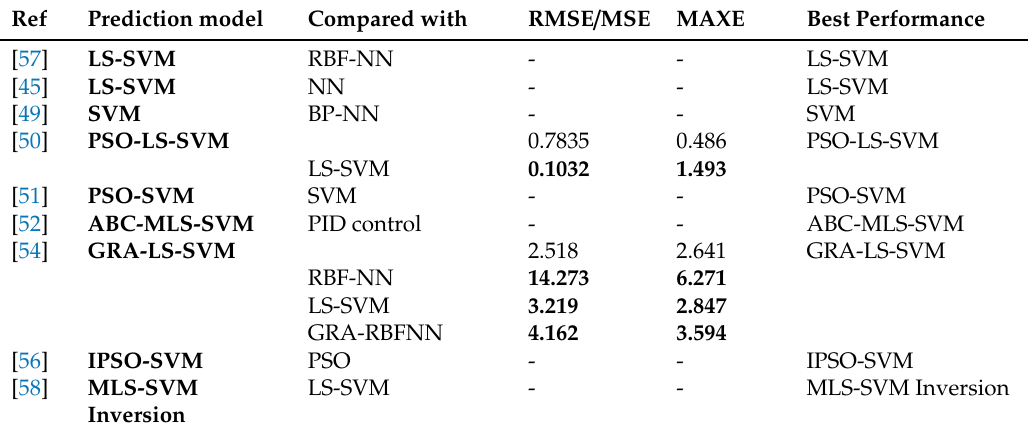
Table 2. Comprehensive analysis of soft sensor models based on SVM (for the list of abbreviations see Table